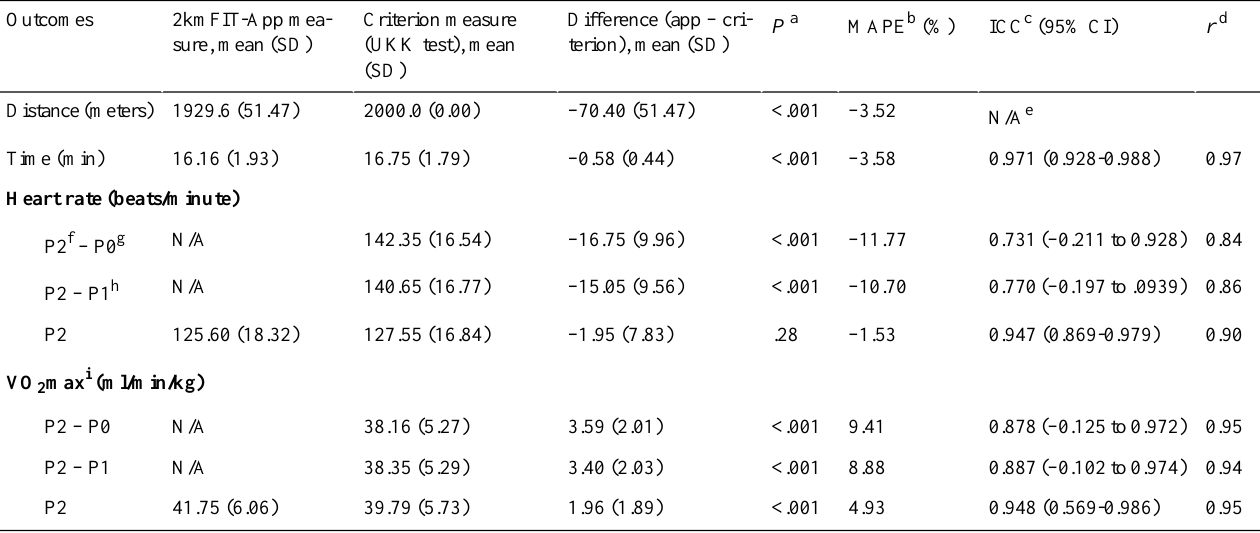
Table 3. Validity of 2km FIT-App (Android version) in comparison with criterion measures (UKK